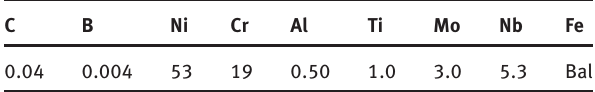
Table 1: Chemical composition of GH4169 alloy